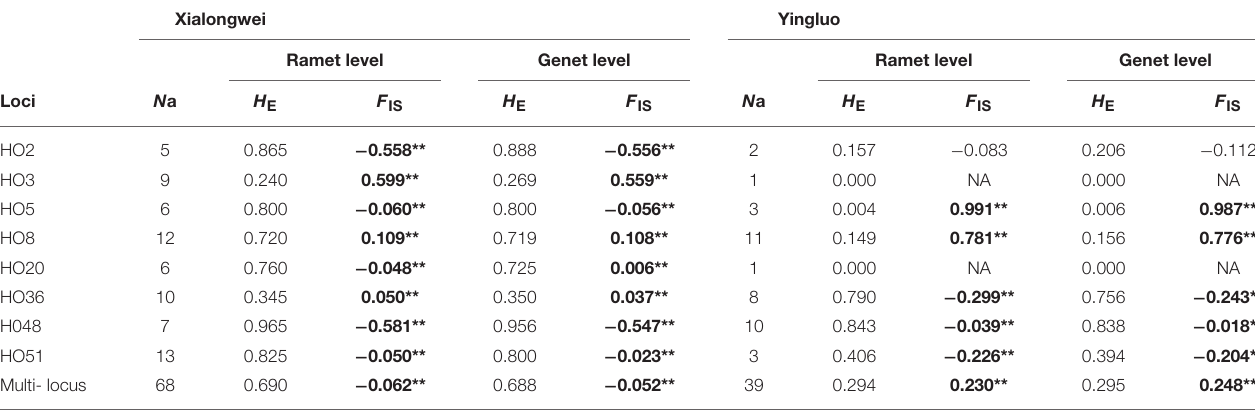
TABLE 3 | Number of alleles ( N a), expected heterozygosity ( H E ), and inbreeding coefficient ( F IS ) at ramet and genet levels of Halophila ovalis populations in Xialongwei and Yingluo.